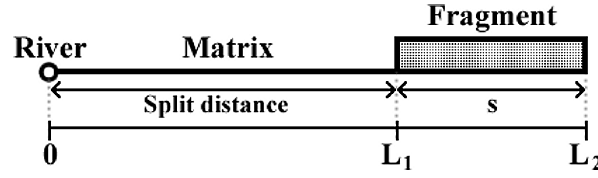
Figure 1. The spatial configuration for the habitat split model. The model has three main landscape elements: the river (or any aquatic breeding habitat), at L 0 , the inhospitable matrix and the forest fragment. Split distance is defined by L 1 while fragment size ( s ) is defined by L 2 { L 1 .